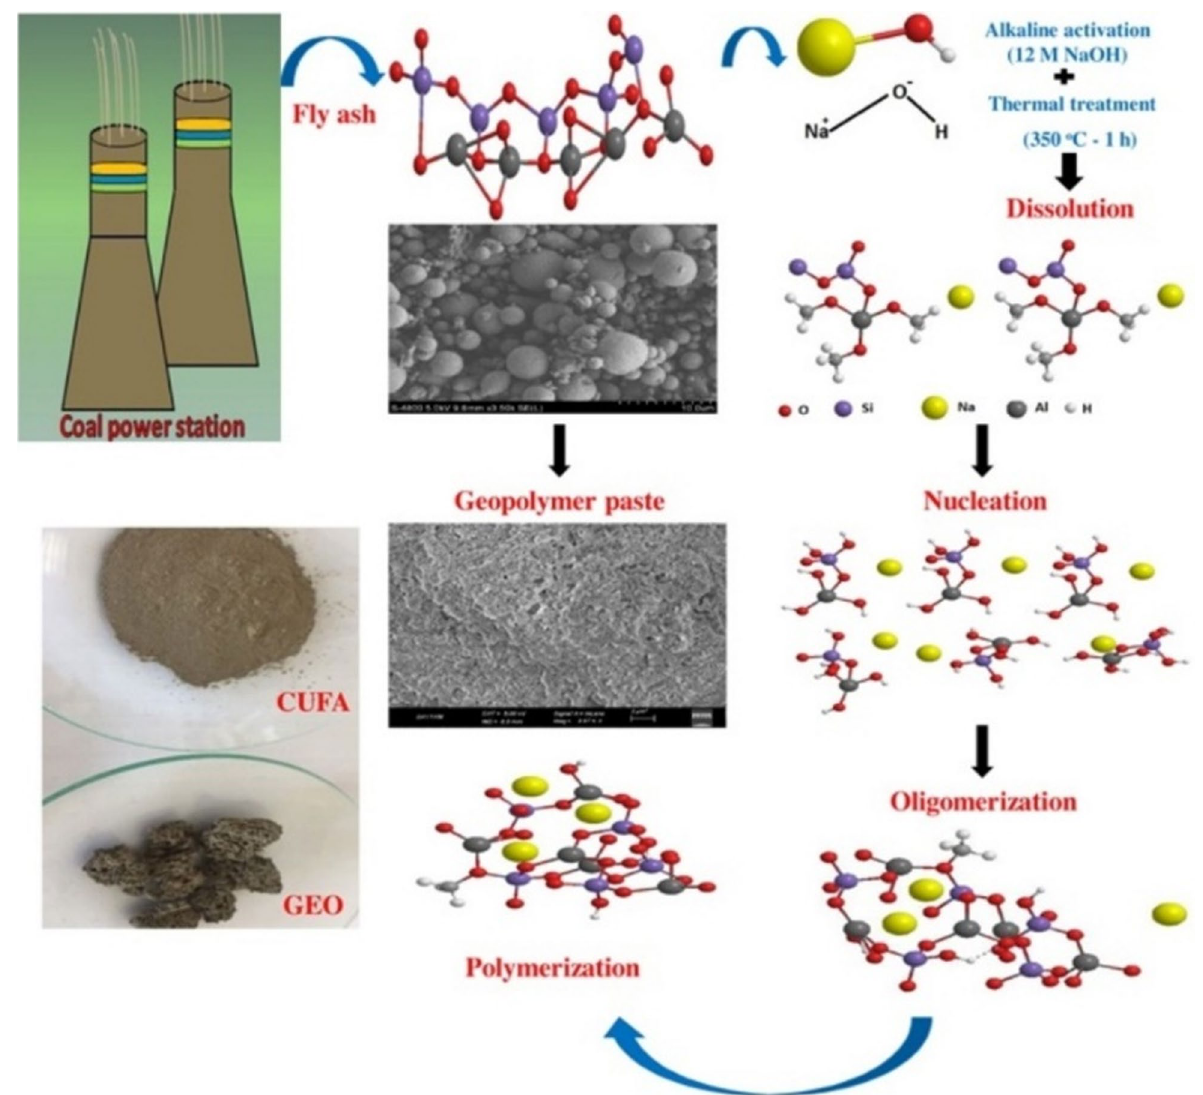
Fig. 27 Geopolymerization of FA (Acisli et al.